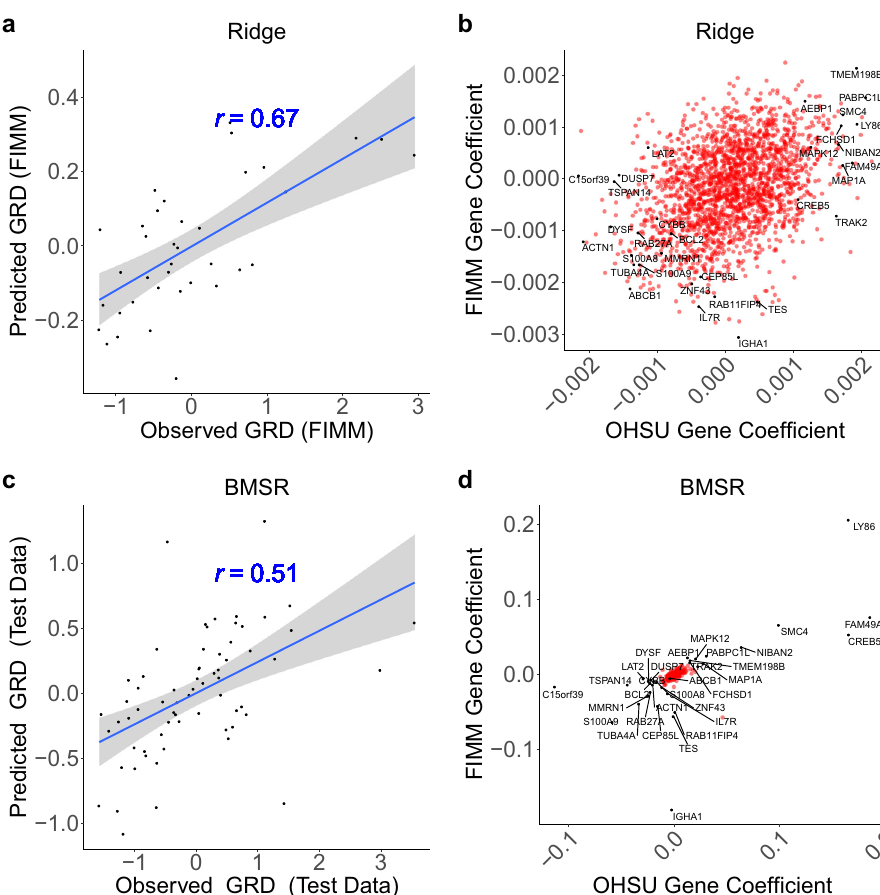
Fig. 3 Integrative analysis reveals growth-, apoptosis-, and drug ef fl ux-associated biomarkers of general response across drugs. a , c Observed ( x axis) versus model-predicted ( y axis) GRD. a Expression-based ridge regression model trained on OHSU samples ( n = 292) and tested on FIMM samples ( n = 37). c Expression-based Bayesian multi-source regression (BMSR) model trained using fi vefold cross-validation on combined OHSU and FIMM datasets ( n = 263) and tested on held-out fold yielding median performance across the fi vefolds ( n = 66). b , d Coef fi cients of genes ( n = 2132) in OHSU ( x axis) or FIMM ( y axis) datasets following b training of ridge regression model independently on both datasets or d training of BMSR model simultaneously on entirety of both datasets ( n = 329). GRD is computed across drugs common to OHSU and FIMM datasets. r : Pearson correlation; dashed line: identity line; blue line: linear regression fi t; gray shading: 95% con fi dence interval. Labeled genes were those having extremal (Stouffer ’ s p < 0.01) combined coef fi cients across both datasets, as well as ABCB1 (i.e., MDR1